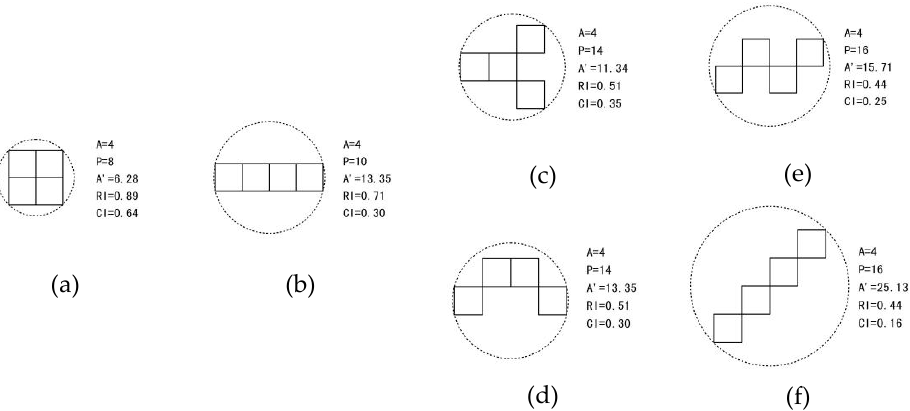
Figure 5. Examples of compactness calculation for external contour: ( a )–( f ) are abstract examples with different areas and perimeters.